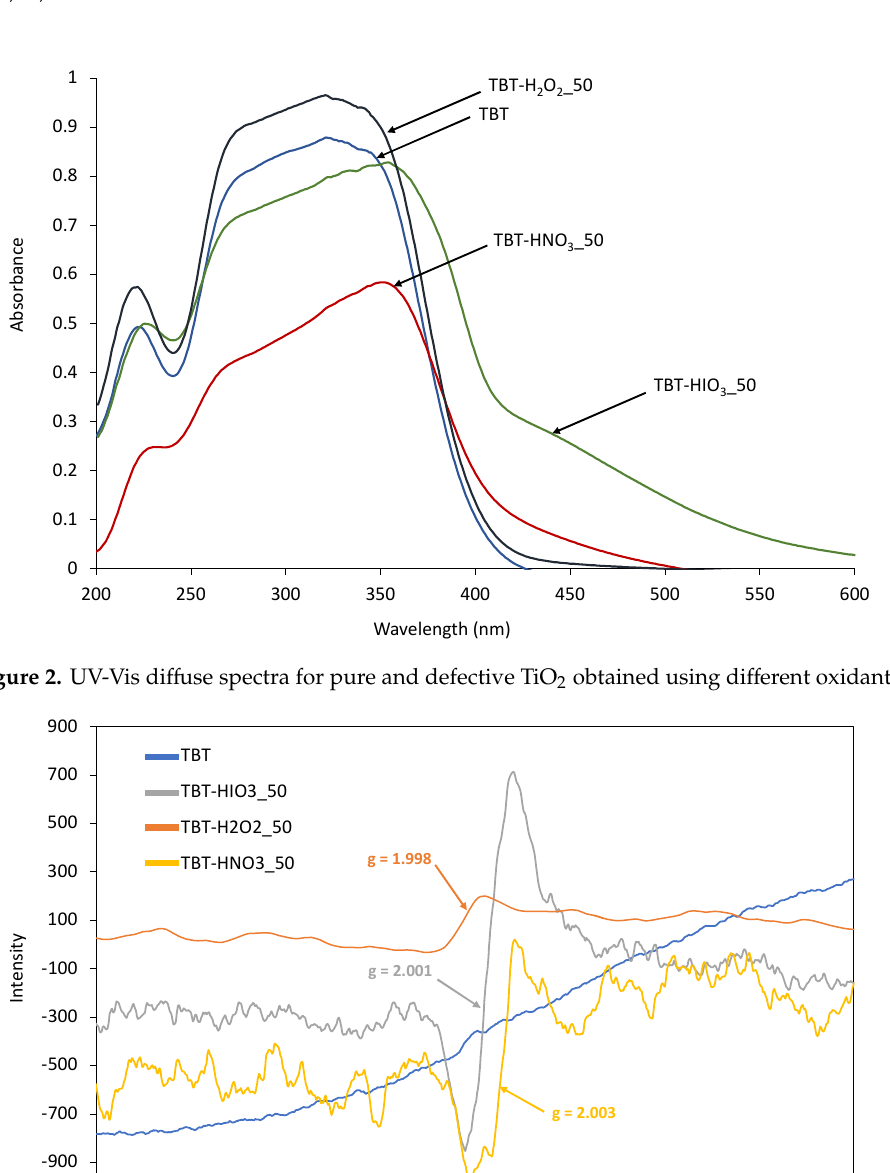
Figure 2. UV-Vis diffuse spectra for pure and defective TiO 2 obtained using different oxidants.